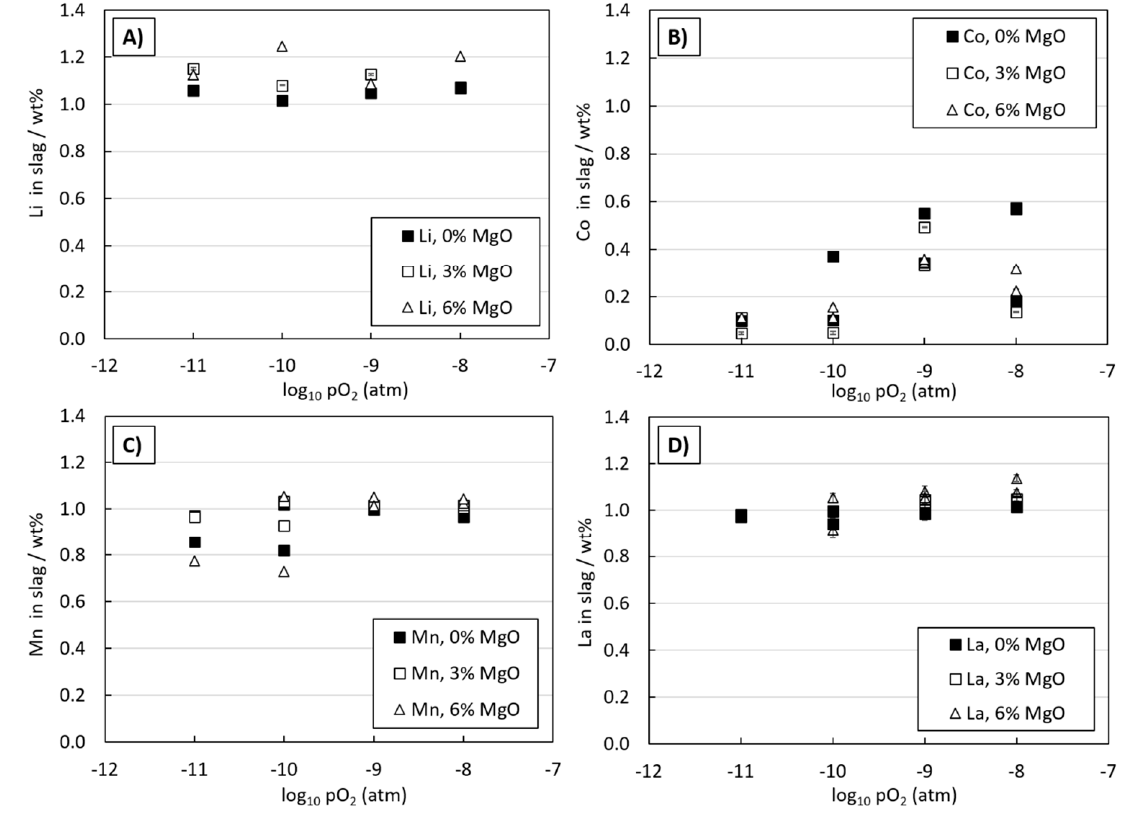
Figure 3. Trace element ( A ) Li, ( B ) Co, ( C ), Mn, and ( D ) La concentrations in the slags as a function of oxygen partial pressure at 1300 °C.